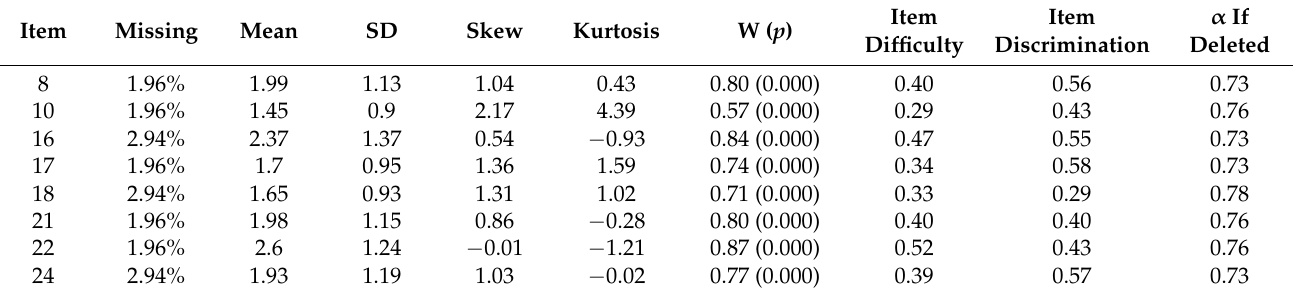
Table 7. The concept of oral pain and